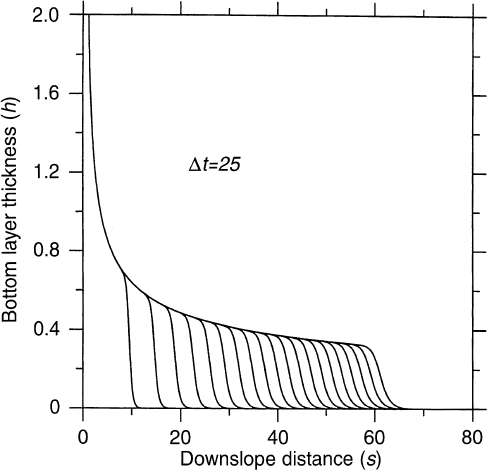
Fig. 6. A time set of successive profiles of the bottom layer thickness, h (cid:133) s (cid:134) , in the down slope direction as computed from Eqs. (7), (22) with boundary conditions h (cid:136) 2 at s (cid:136) s 1 (cid:136) 1 : 17, (which is equivalent to Q 1 (cid:136) Q ) and h (cid:136) 0 at s )1 . Non-dimensional time interval between consecutive profiles (cid:68) t (cid:136) 25